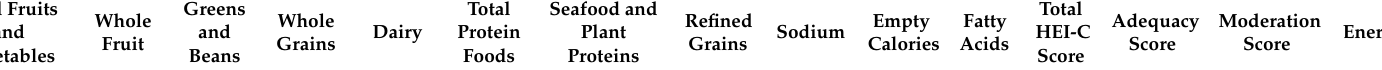
Total Fruits Greens Total Seafood and Whole Whole and and Dairy Protein Plant Fruit Grains Vegetables Beans Foods Proteins 1.00